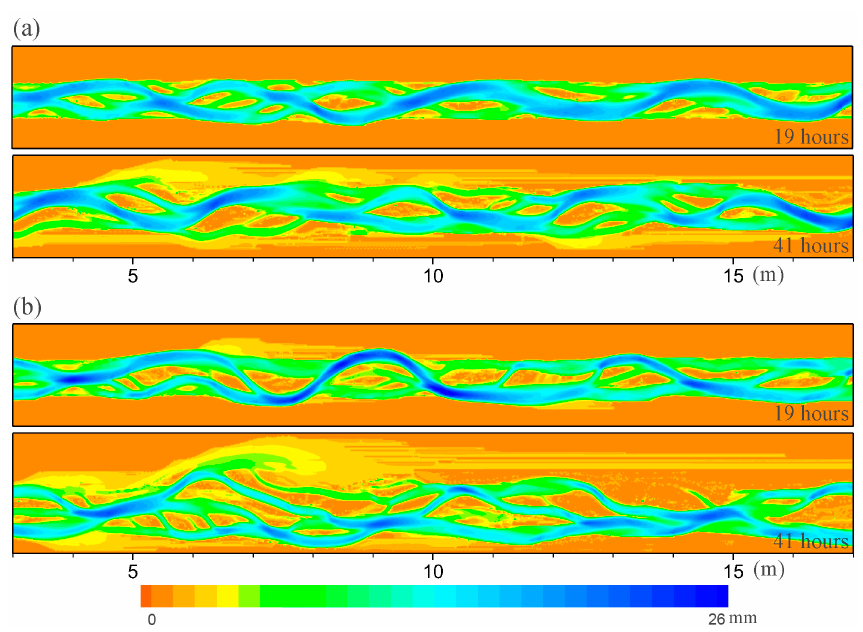
Figure 7. Braiding configurations ( a ) without and ( b ) with the effect of secondary flow.